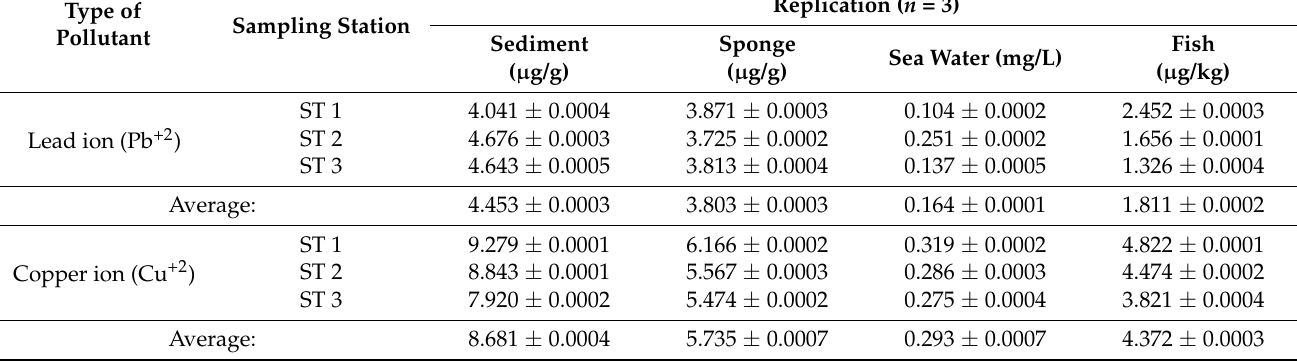
Table 7. Heavy metal pollutant (HM) concentration